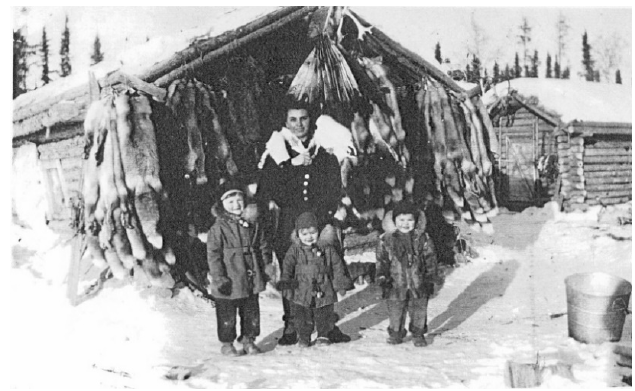
Figure 4. Cathy’s grandmother, Evelyn Oak, and her three daughters at the trapline in the Northwest Territories.